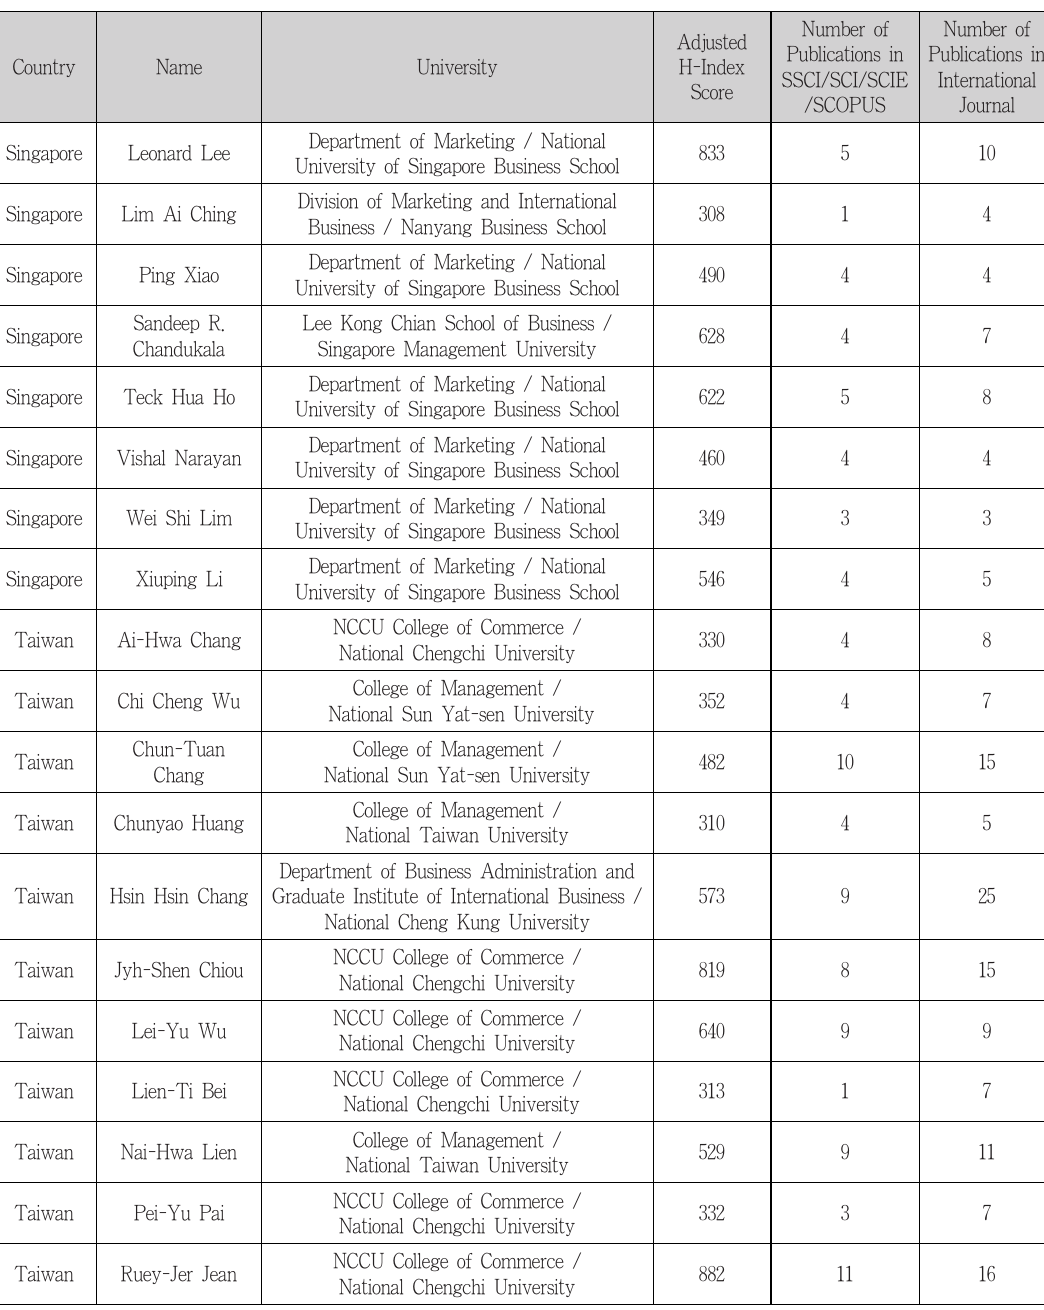
<Table 1> 100 Research-Active Scholars in Asia